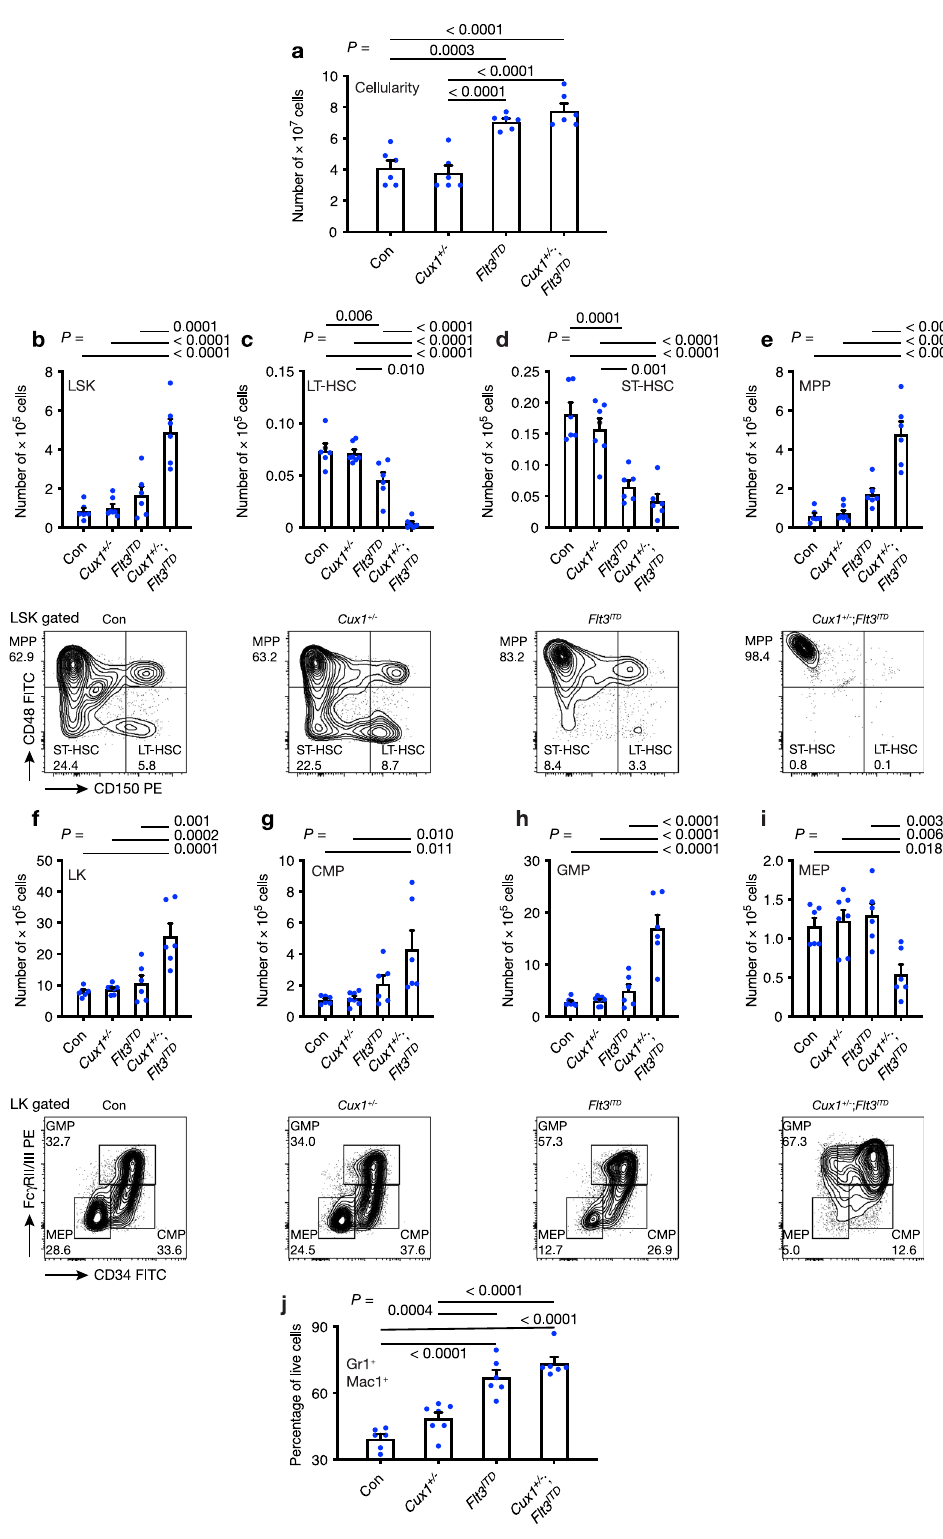
Fig. 4 Defective hematopoietic stem and progenitor cell homeostasis in Cux1 + / − ; Flt3 ITD mice. a Total bone marrow cellularity of two legs from control Con ( n = 6), Cux1 + / − ( n = 7), Flt3 ITD ( n = 6) and Cux1 + / − ; Flt3 ITD ( n = 6) mice at 10-12 weeks of age. b – e Plots showing absolute numbers of LSK ( b ), LT- HSC ( c ), ST-HSC ( d ) and MPP ( e ) cells in mice from the indicated genotypes. Representative fl ow cytometry plots are shown below each bar plot. ( f – i ) Plots showing absolute numbers of LK ( f ), CMP ( g ), GMP ( h ) and MEP ( i ) cells in mice from the indicated genotypes. Representative fl ow cytometry plots are shown below each bar plot. j Percentage of Gr1 + Mac1 + myeloid cells in the bone marrow of mice from the indicated genotypes ( n = 6 per group). All plots show mean + s.e.m. Each circle represents one mouse. One-way ANOVA with Tukey ’ s test for multiple